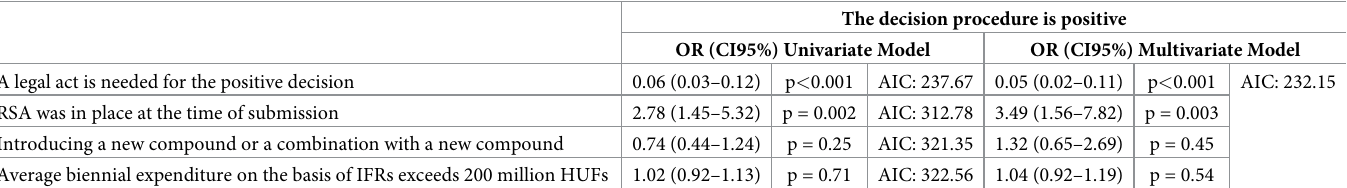
Table 2. Results of the logistic regression analyses with the outcome of the decision being positive as the dependent